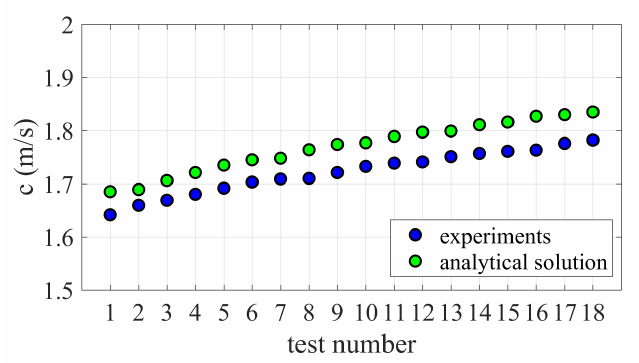
Figure 5. Comparison between theoretical and experimental wave celerity for all experimental